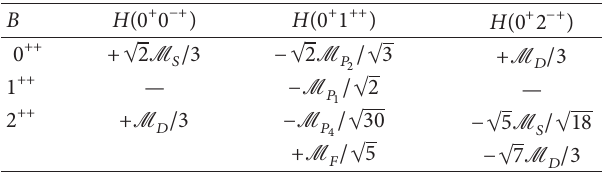
Table 9: Partial wave amplitudes hybrid 𝐻 decaying into a 𝑃 -wave and pseudoscalar